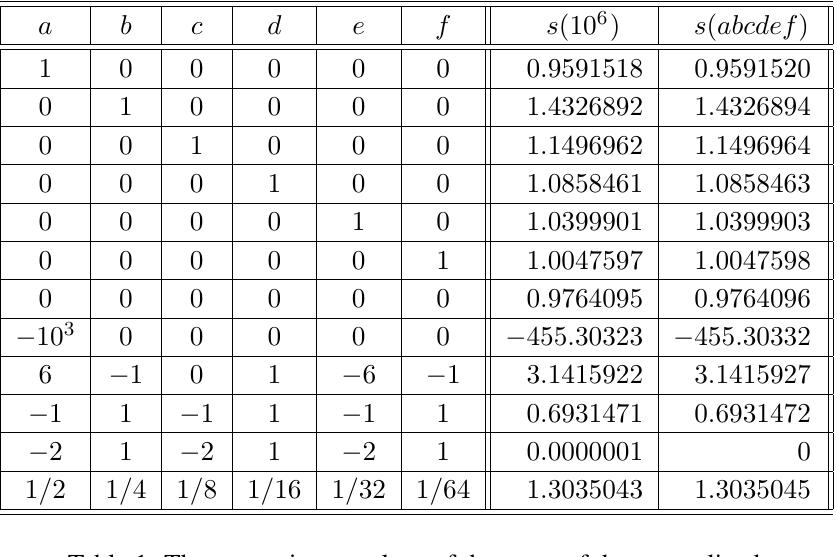
Table 1: The approximate values of the sums of the generalized harmonic series with periodically repeating